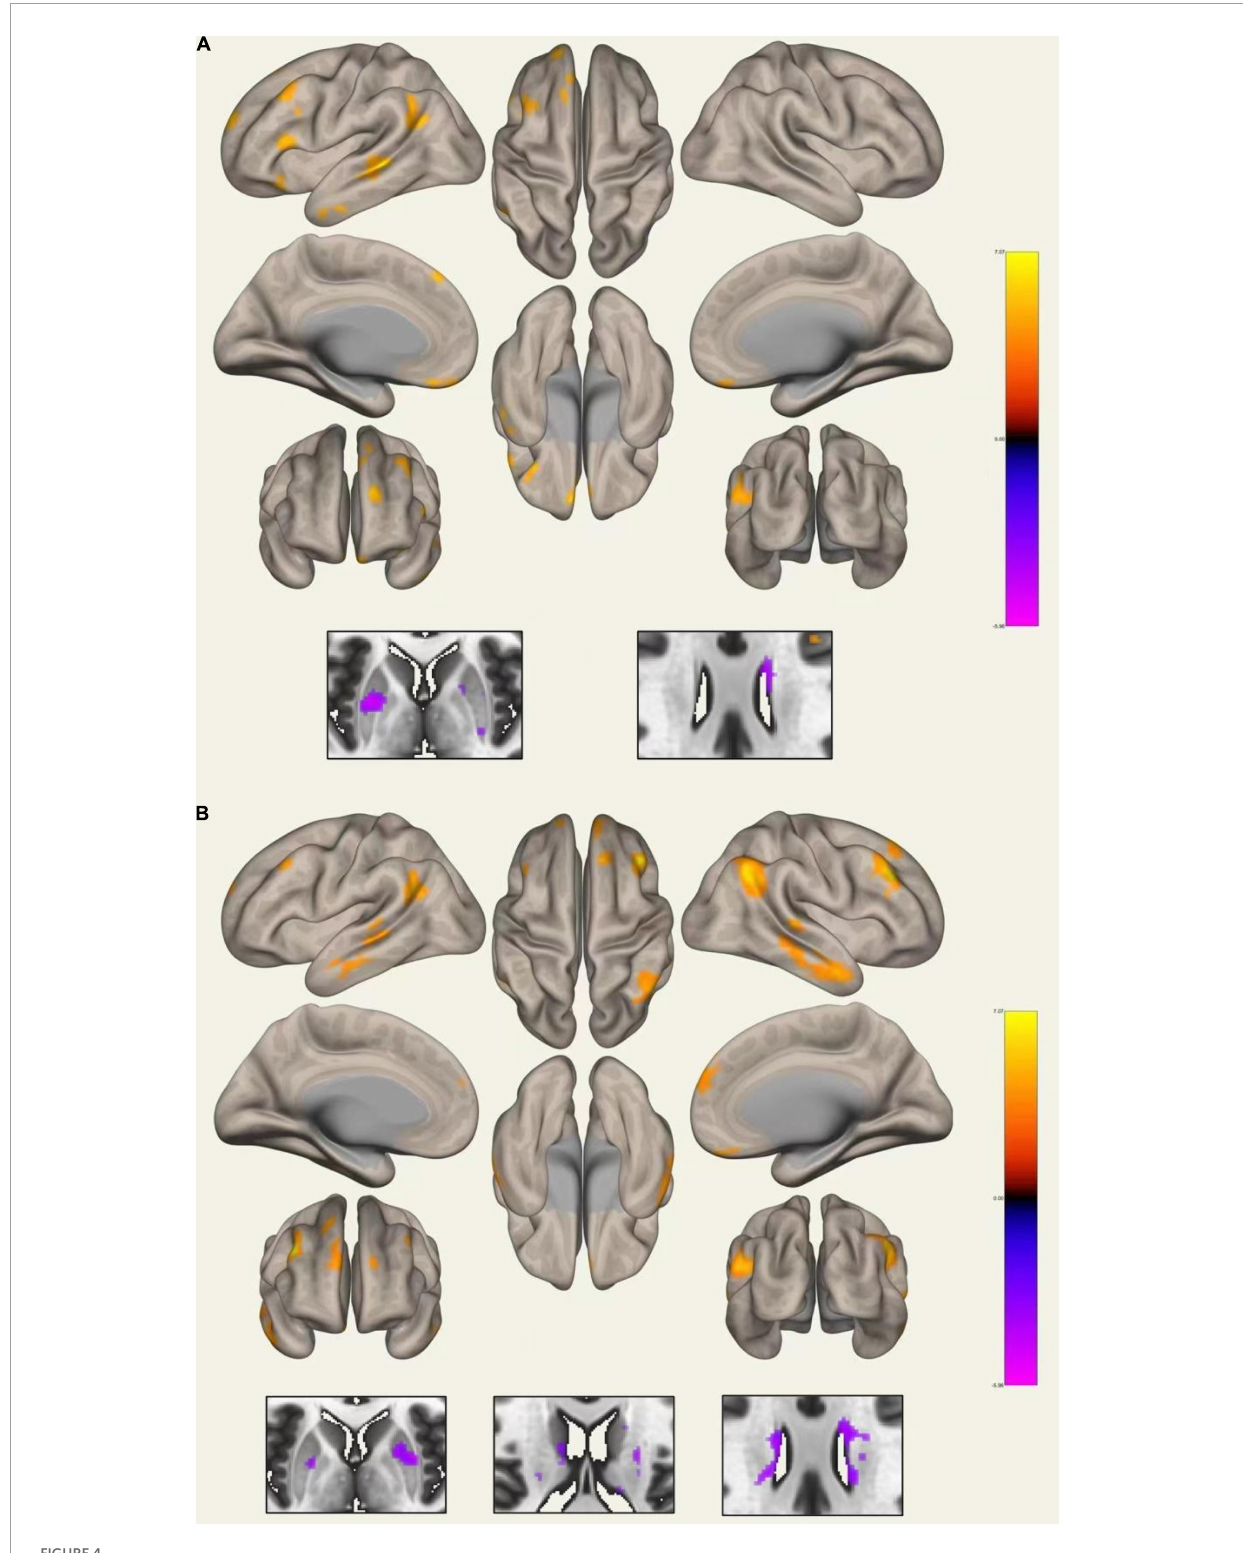
FIGURE4 Whole-brain functional connectivity of the left (A) and right (B) putamen.